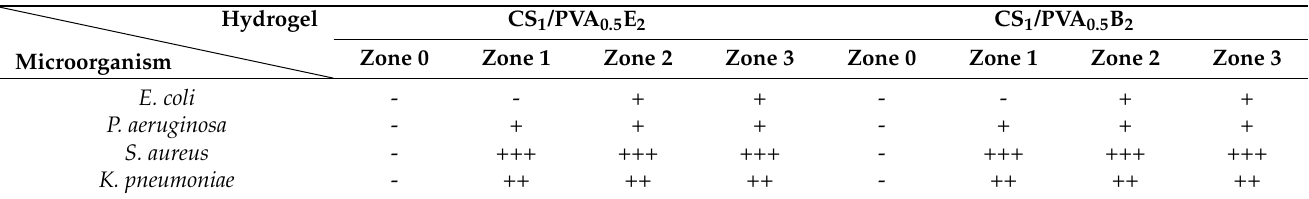
Table 2. Antibacterial properties of the CS 1 /PVA 0.5 E 2 and CS 1 /PVA 0.5 B 2 hydrogels against E. coli , P. aeruginosa , S. aureus , and K. pneumoniae .